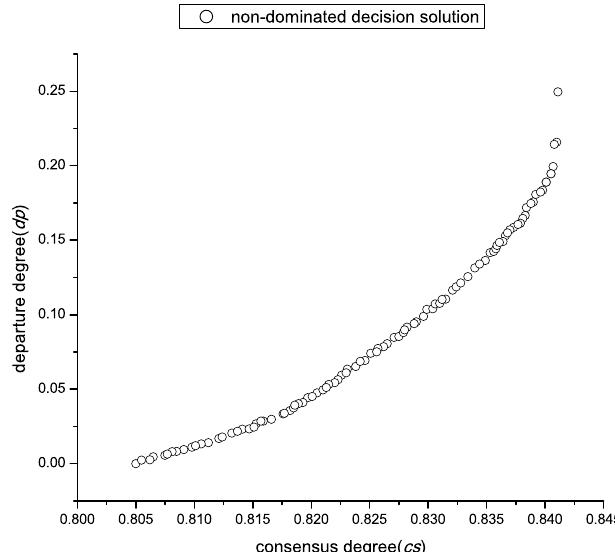
Figure 2: Obtained non-dominated decision solutions of the multi-objective optimization problem of initial decision preferences given by DMs.